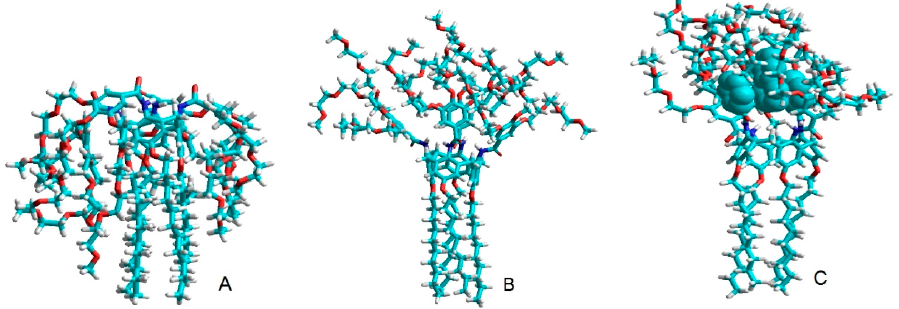
Figure 7. Possible conformers of calixarene 1a ( A , B ) and 1a + NAP complex ( C ) in water.